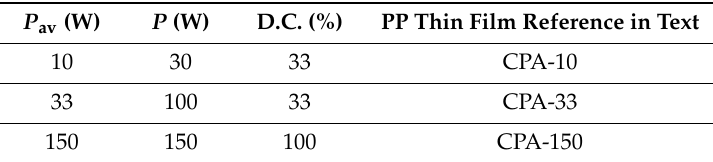
Table 1. Plasma deposition